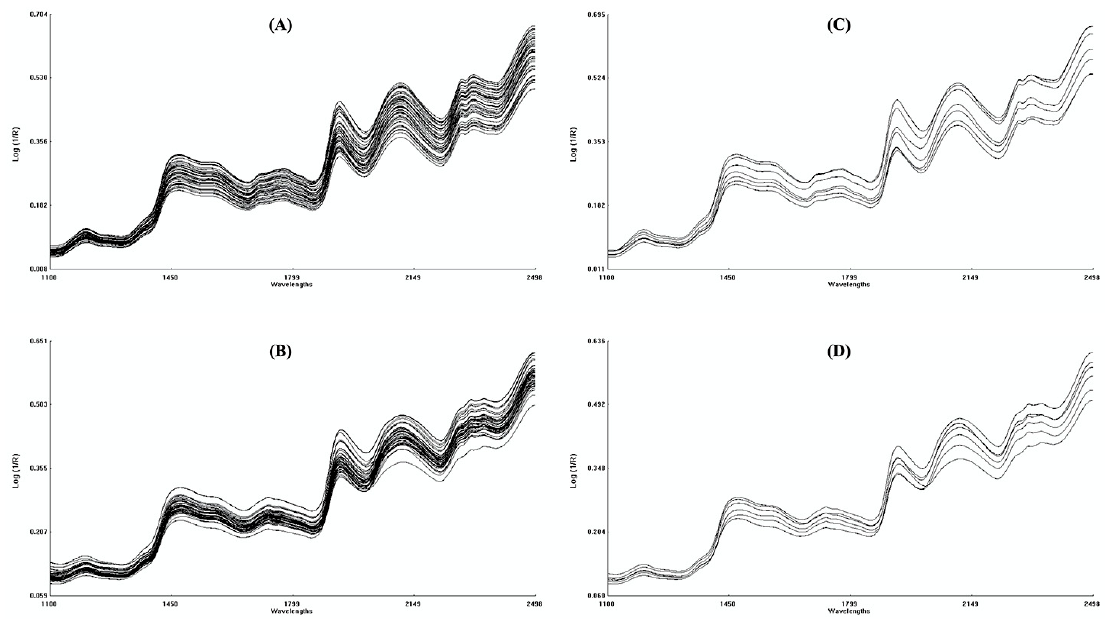
Figure 2. NIR spectra of the seven taro accessions, with 126 corm ( A ) and 120 shoot ( B ) samples, and external set validation with 21 samples for corms ( C ) and 18 shoot samples ( D ). Wavelengths from 1100 to 2498.2 nm of the NIR range.